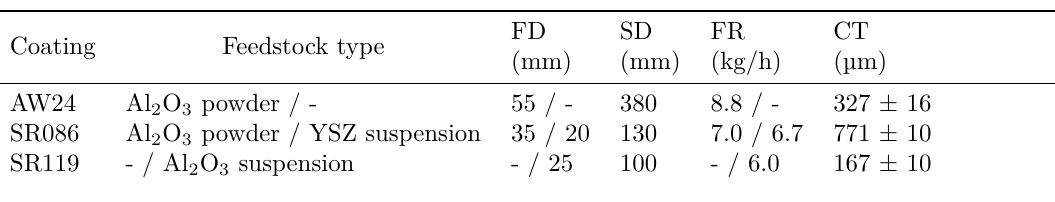
Table 1. Spraying conditions for powder/suspension.